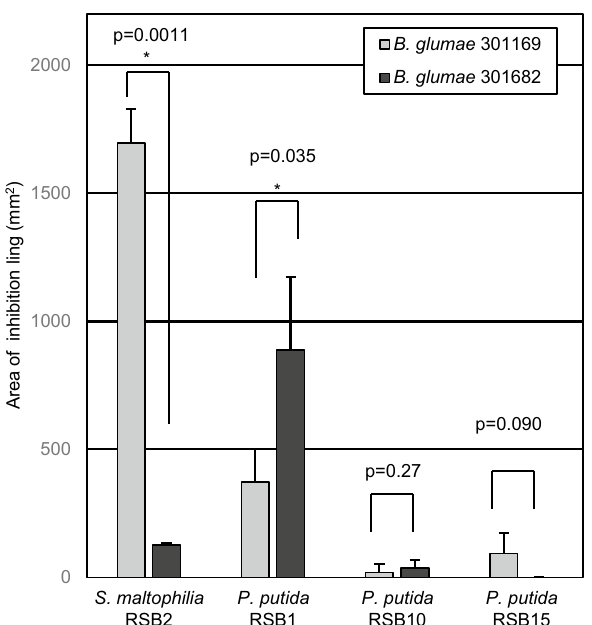
Figure 4. Competitive inhibition test of RSBs to B. glumae 301169 and 301682. RSBs were spotted on B. glumae 301169 or 301682-embedded plates. Area of inhibition ling (halo) was measured 7 days after spotting (n = 3). Statistical significance was subsequently determined through Student’s t-test, * p < 0.05. Results are representative of three experiments.